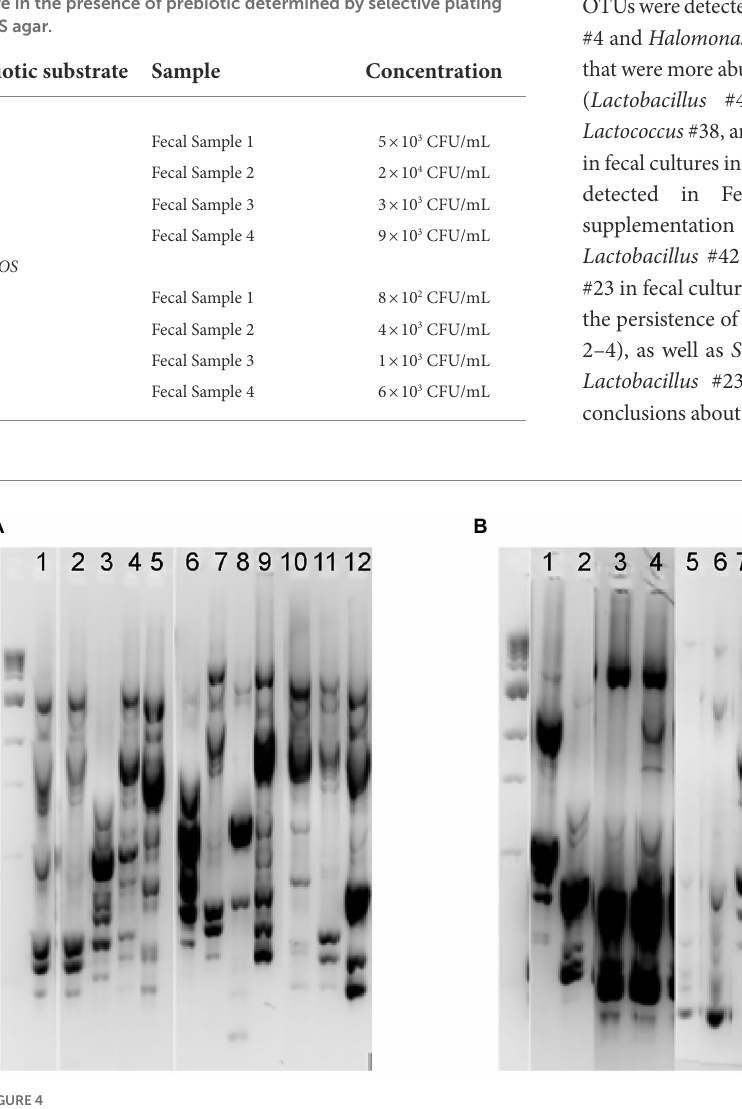
FIGURE 4 RAPD fingerprinting demonstrated differences in putative Lactobacillaceae in sauerkraut and prebiotic-enriched fecal communities. Unique RAPD fingerprints of the 27 bacterial isolates from Lactobacillus selection agar that were chosen for 16S rRNA gene sequencing. (A) Isolates from sauerkraut brine before (Lanes 1–5) and following enrichment with 1% XOS (Lanes 6–9) or 0.5% FOS and 0.5% GOS (Lanes 10–12). (B) Isolates from fecal samples enriched with XOS; samples were from Fecal 1 (Lanes 1–2), Fecal 2 (Lanes 3–4), Fecal 3 (Lanes 5–7), and Fecal 4 (Lanes 8–10). (C) Isolates from fecal samples enriched with 0.5% FOS and 0.5% GOS; samples were from Fecal 1 (Lanes 1–2), Fecal 2 (Lane 3), Fecal 3 (Lane 4), and Fecal 4 (Lane 5). The full gel images from which these unique fingerprints were cropped are shown in Supplementary Figure 1, which indicates those lanes that were selected for this